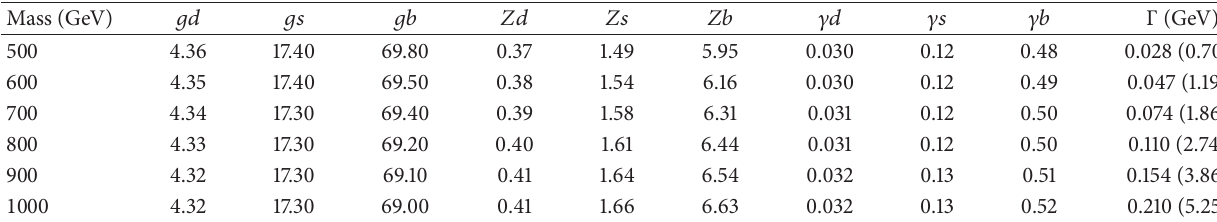
Table 4: The same as Table 3, but for PII (PIII) parametrization.